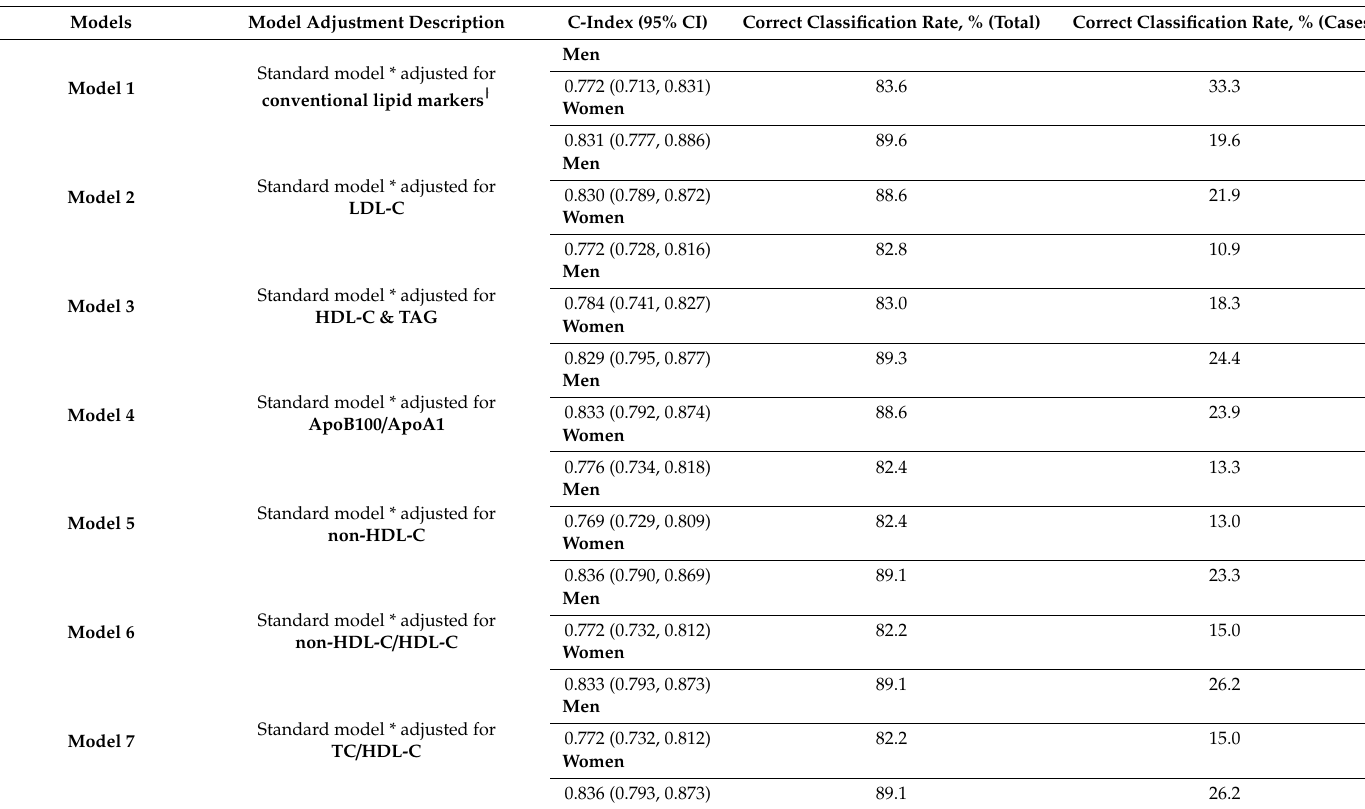
Table 5. Discrimination-ability parameters of multivariate models adjusted for different combinations of lipid markers over the 10-year first fatal/non-fatal cardiovascular disease event ( n = 2020).